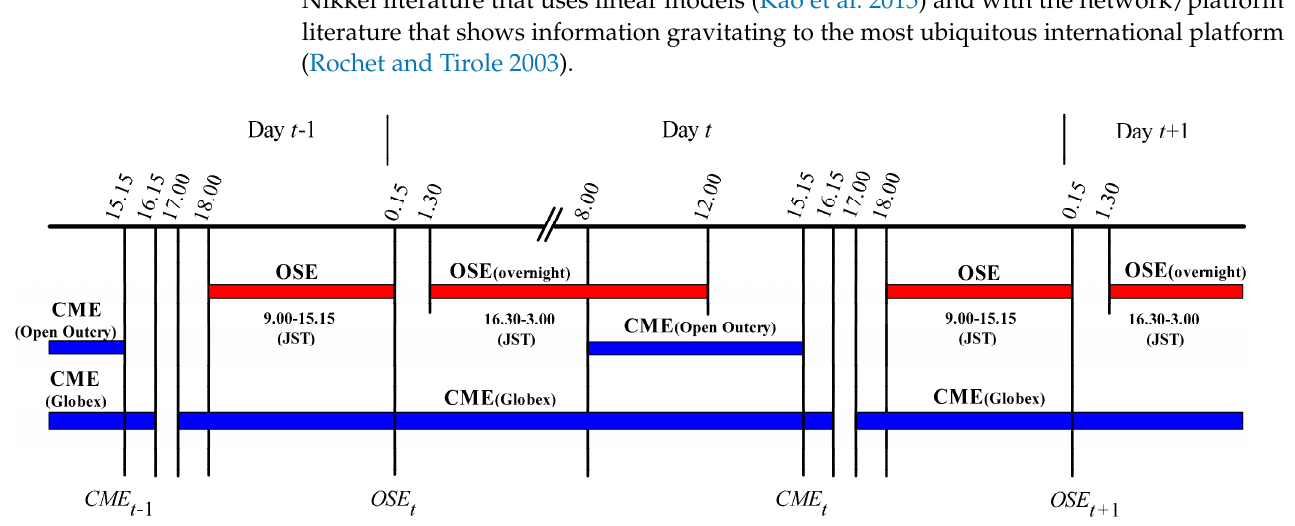
Figure 2. Trading hours of the OSE and CME. Notes: The time is Central Standard Time (CST) unless otherwise shown. The bottom line shows the time when the OSE, CME settlement prices are generated. For reference, the Nikkei spot market opens 9.00–11.30, 12.30–15.00 (Japan Standard Time, JST), corresponding to 18.00–20.30, 21.30–0.00 (CST). Table 5. Nonsynchronous trading time